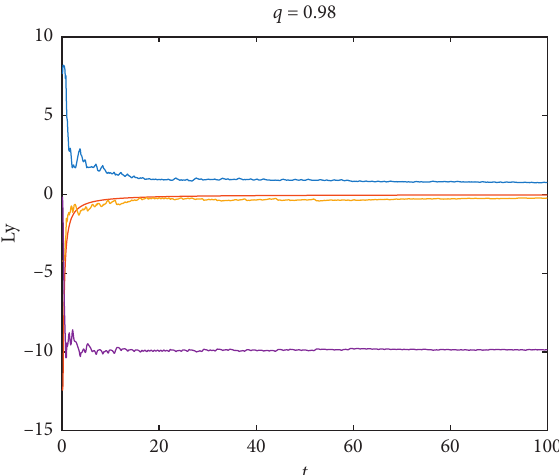
Figure 3: The Lyapunov exponents of system (1) with q � 0.98.